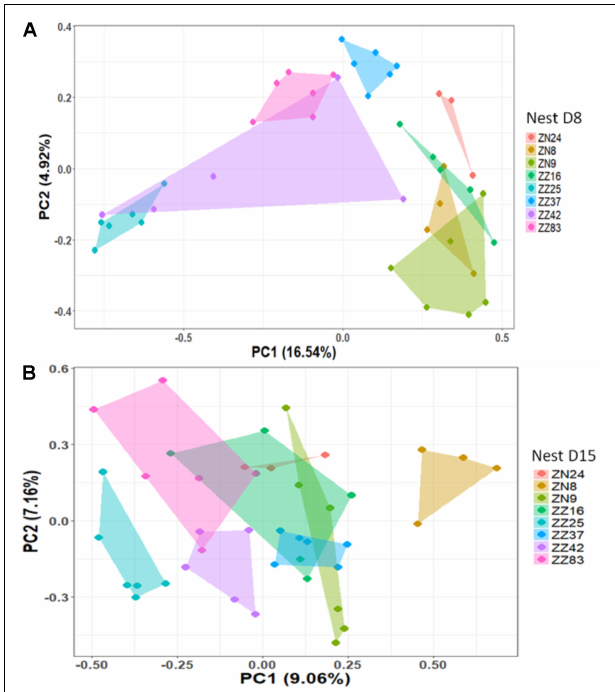
FIGURE 5 | NMDS based on a presence–absence similarity matrix of the cloacal microbiota of the nestlings from the control nests at D8 (A) and D15 (B) . Each color represents a different nest. Numbers in parenthesis refer to the variance explained by the ordination